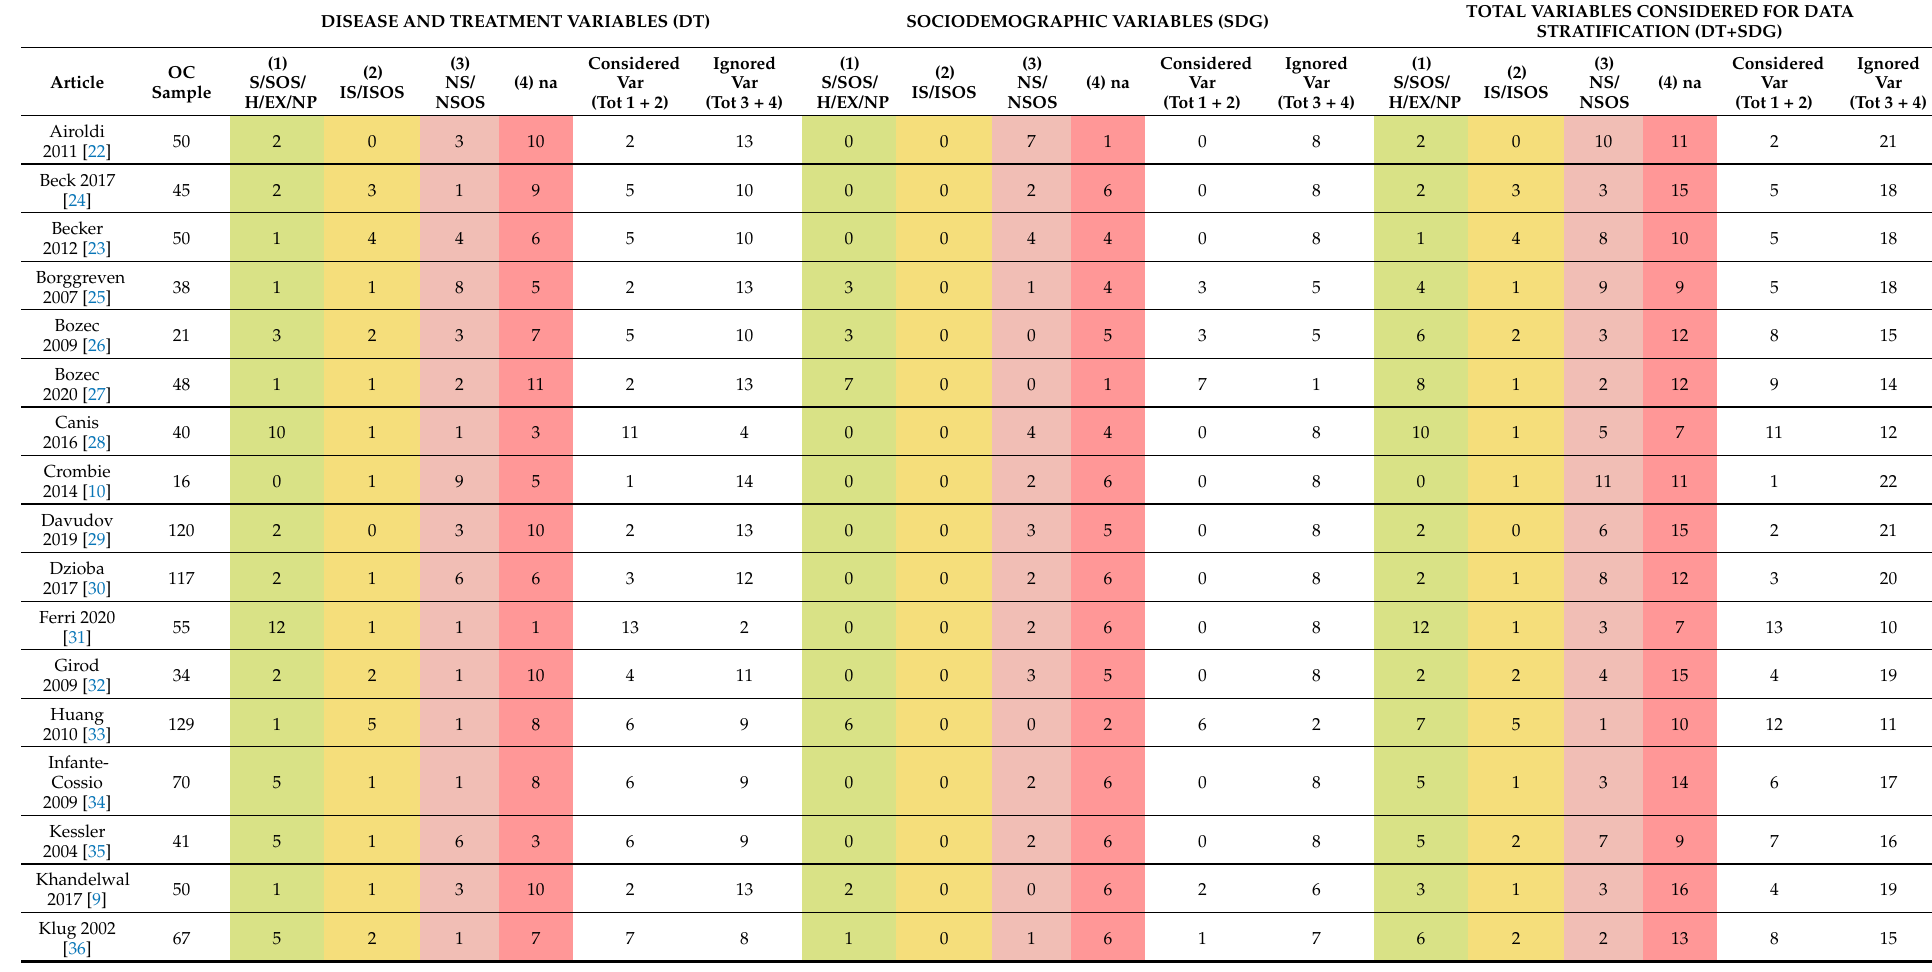
Table 3. Summary of data stratification by DT and SDG variables. Legend to Table 3: Ex = excluded; H = homogeneous; IS = incomplete/inadequate stratification; ISOS = incom- plete/inadequate stratification by oral subsites; na = not available; NP = not present; NS = not stratified; NSOS = not stratified by oral subsites; S = stratified; SOS = stratified by oral subsites. * Studies on patients treated by non-surgical